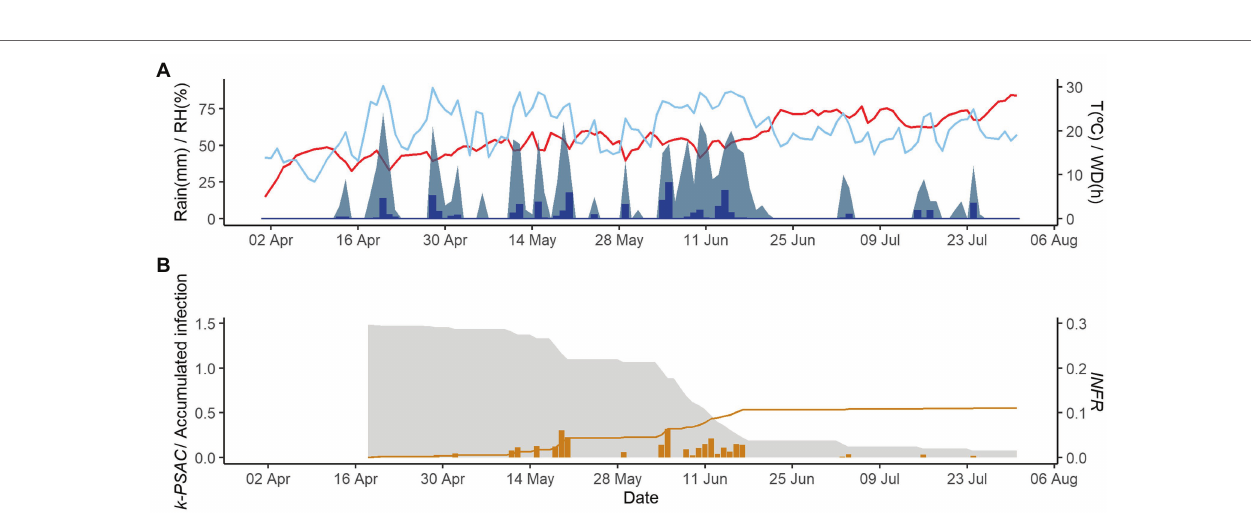
FIGURE 3 | Model output of PCLS for the vineyard in Domini in 2020. (A) Weather variables: air temperature (T, red line in ° C), rain (blue bars in millimeters), leaf wetness duration (WD, light blue area in hours), and relative humidity (RH, blue line in %). (B) Inoculum dose as k - MATR (gray area), daily values of predicted infection (orange bars; average value of INFR L and INFR S ), and accumulated infection during the season (orange